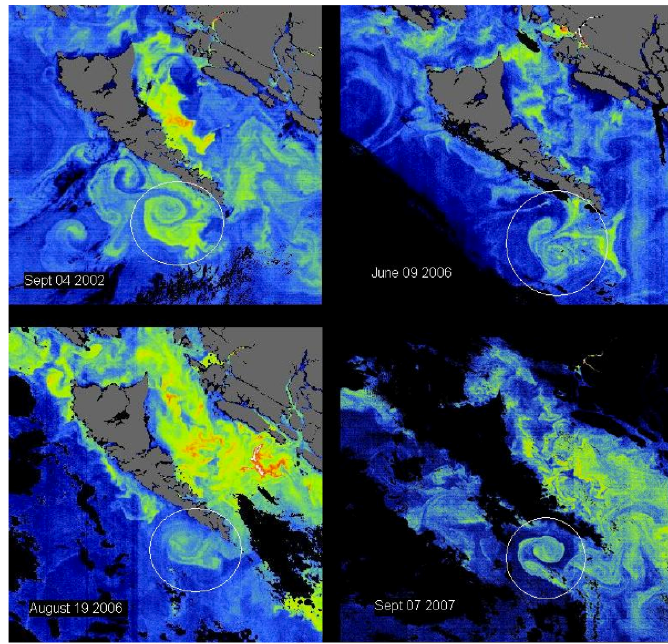
Fig. 1. Representative images from MERIS ocean fluoresence satellite showing eddy dipoles generated near Cape St. James, at the south tip of Haida Gwaii (Queen Charlotte Islands).